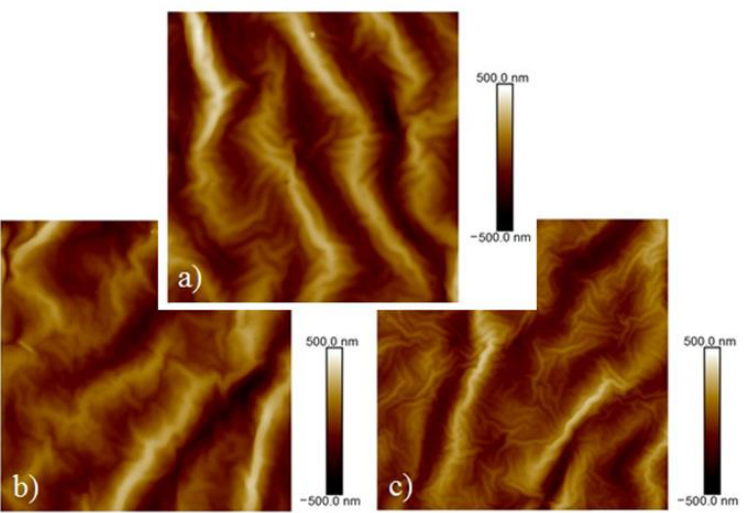
Table 2. The average values of amplitudes and widths of wrinkles generated by sample sputter- ing; determined from 3 × 3 μm AFM images.